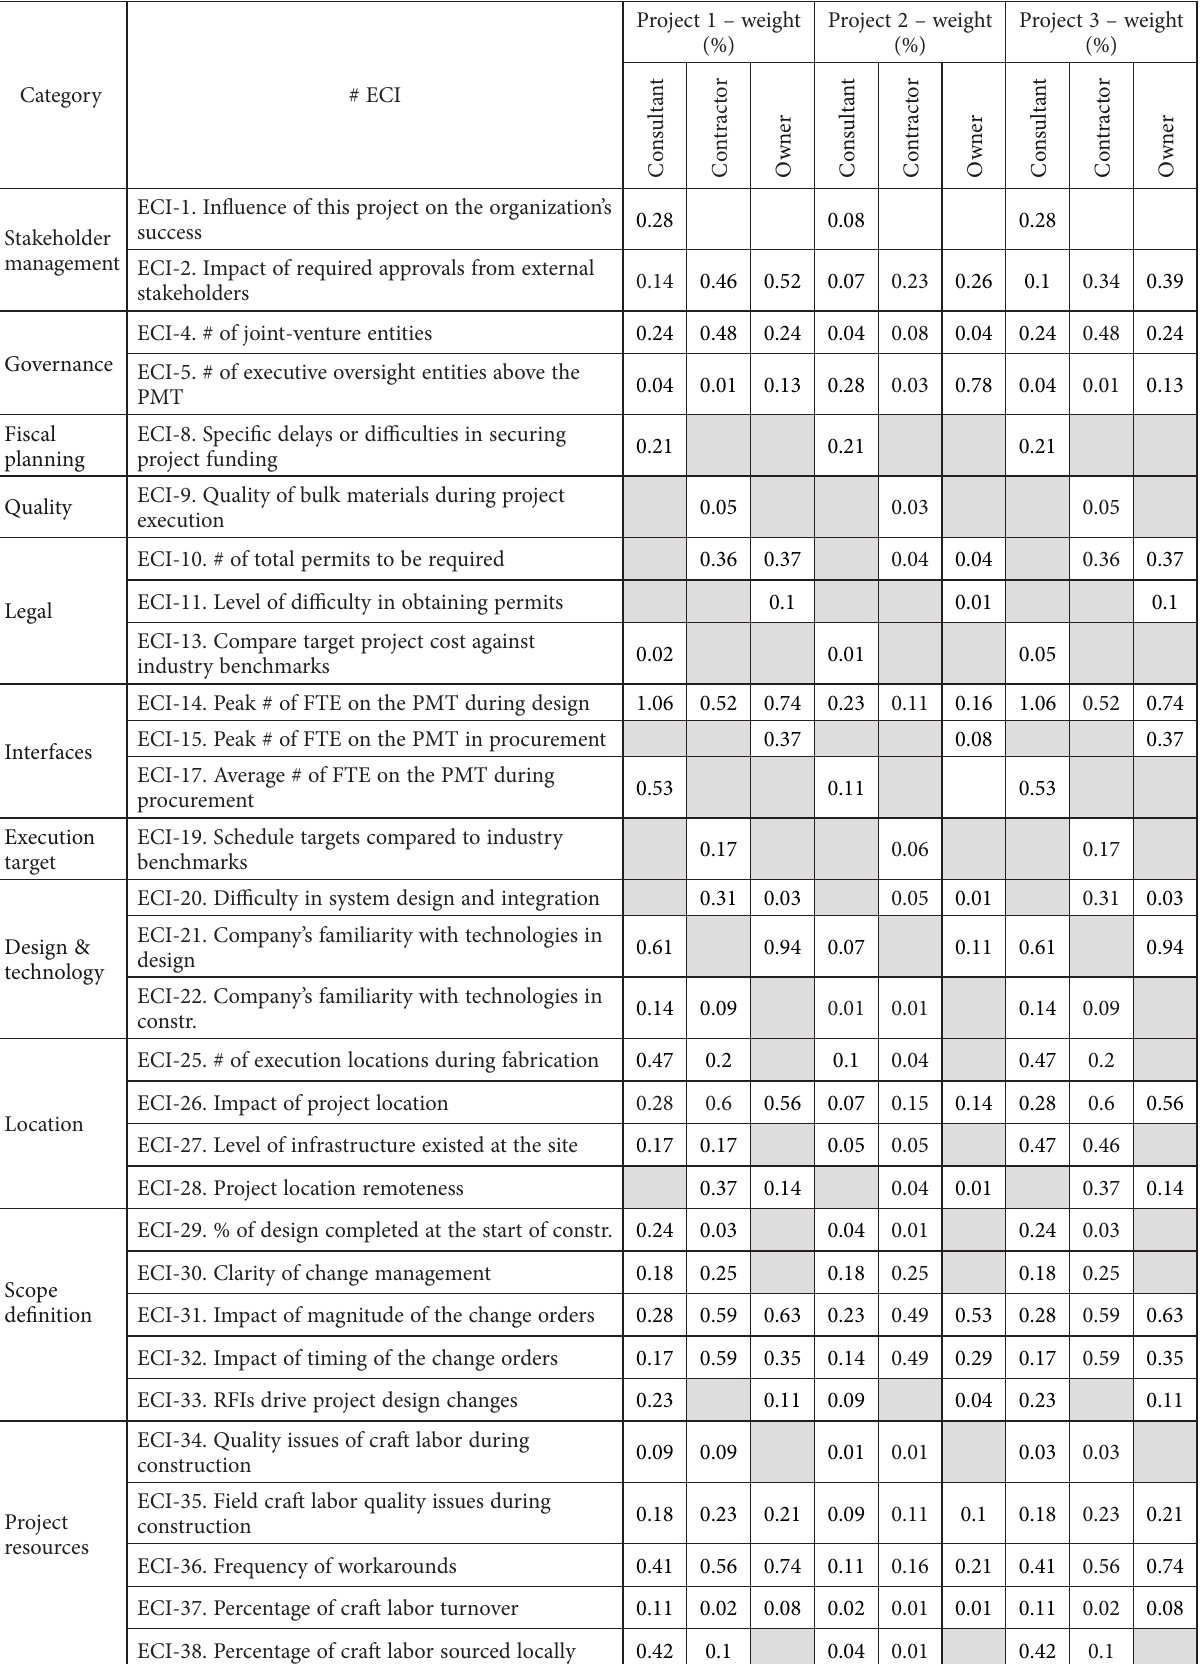
Project 1 – weight Project 2 – weight Project 3 – weight (%) (%)